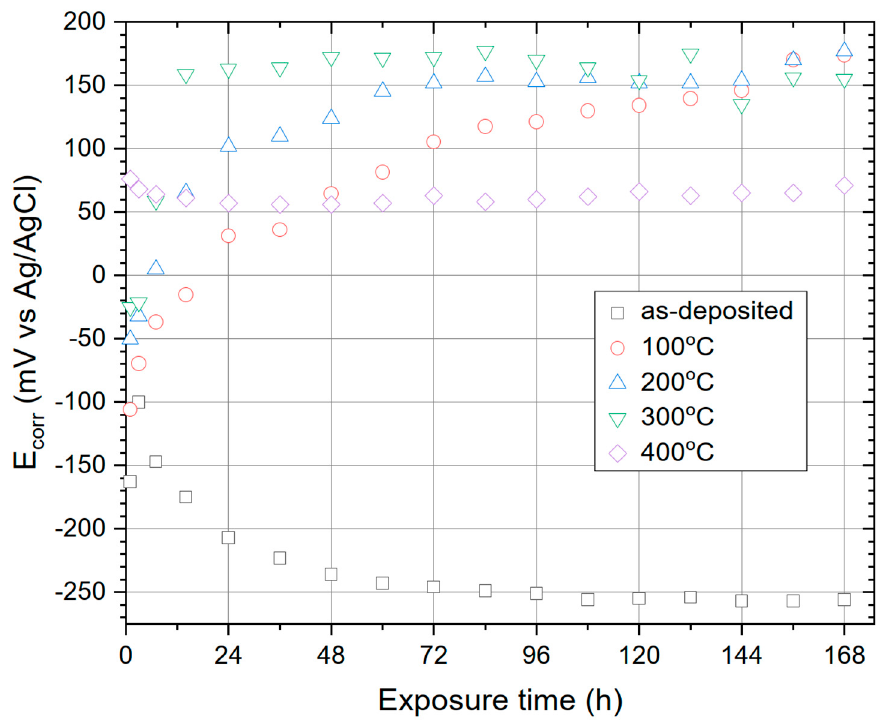
Figure 8. Corrosion potential measured in 0.05 mol dm − 3 NaCl solution during 168 h of exposure of Ni coatings obtained in a plating bath composed of ChCl and EG (1:2 molar ratio) and 1 mol dm − 3 NiCl 2 ·6H 2 O ( j c = 6 mA cm − 2 , 90 min, 70 °C, coating thickness 7–8 μ m).